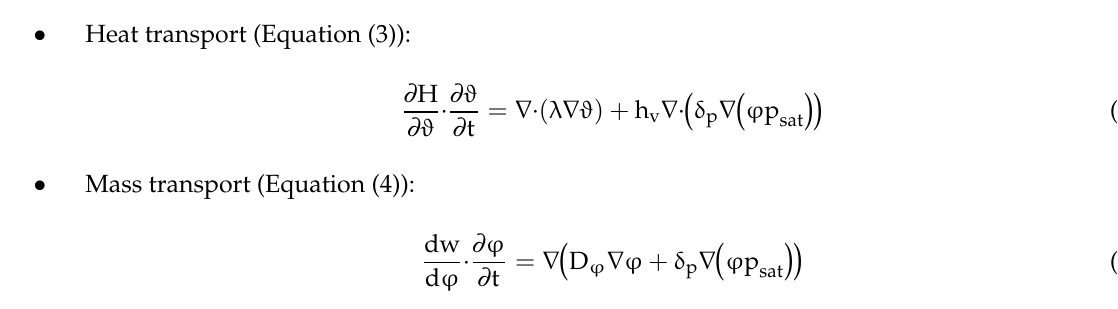
Figure 28. Water content changes for the entire calculation model.